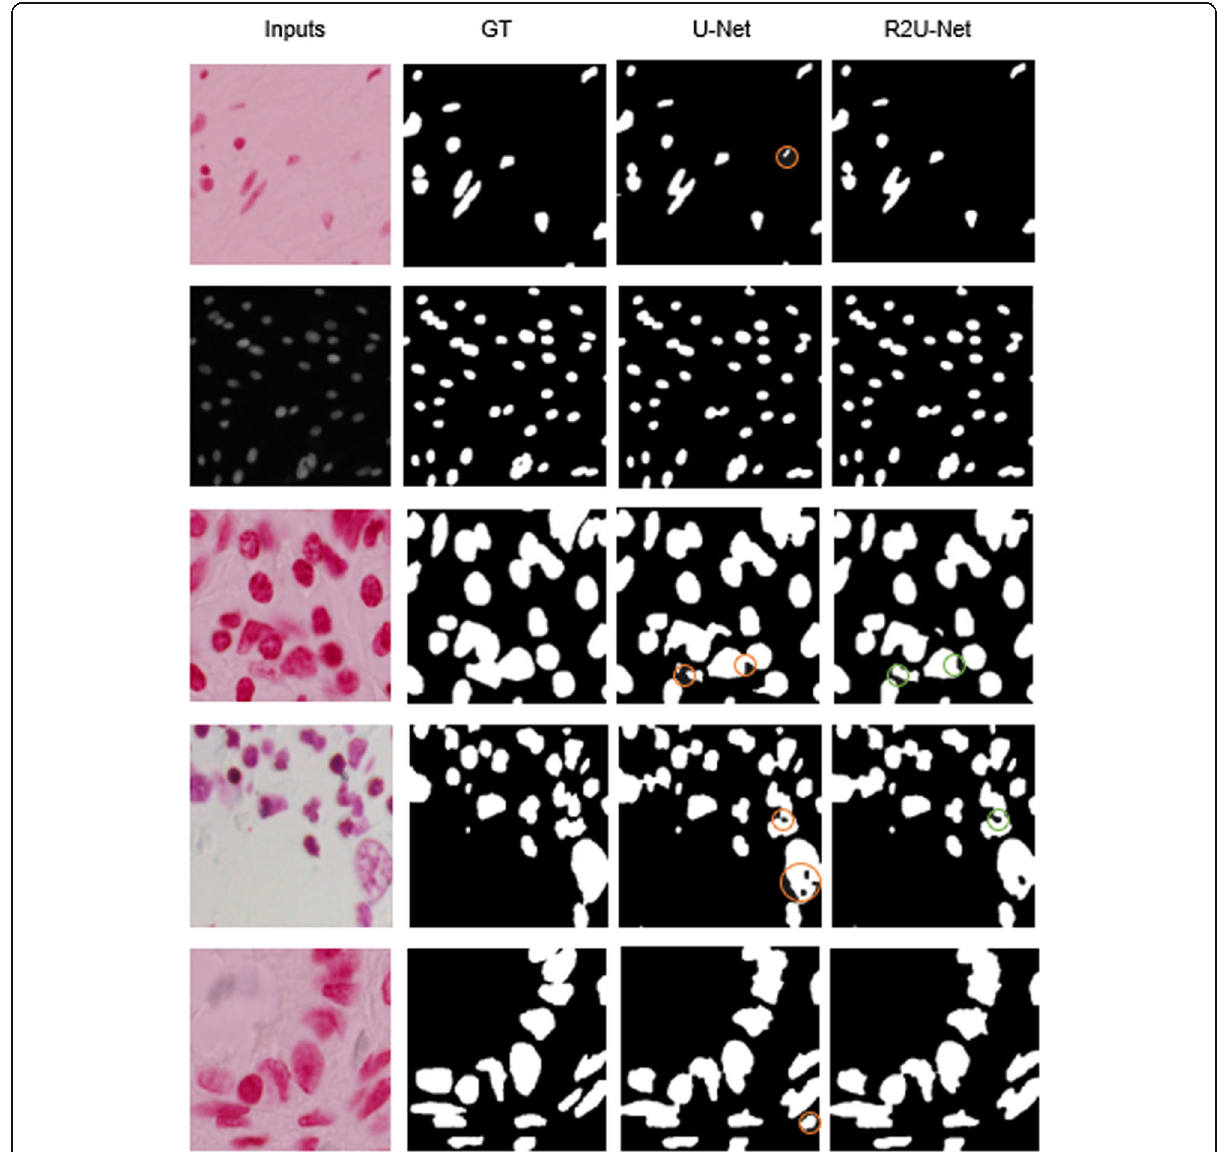
Fig. 13 Qualitative results for both U-Net and R2U-Net models for nuclei segmentation, the first column shows the input samples, the second column shows the corresponding ground truth (GT) masks, the third column shows the outputs from U-Net and the fourth column shows the outputs of R2U-Net model. The orange circles show the false detection by the U-Net